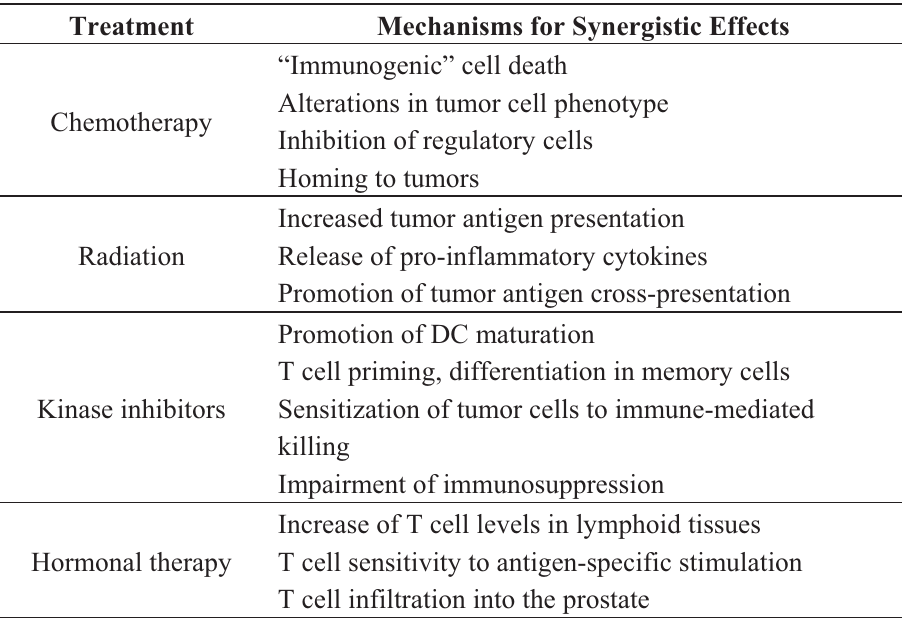
Table 2. Potentiation of the endogenous antitumor immunity with conventional cancer